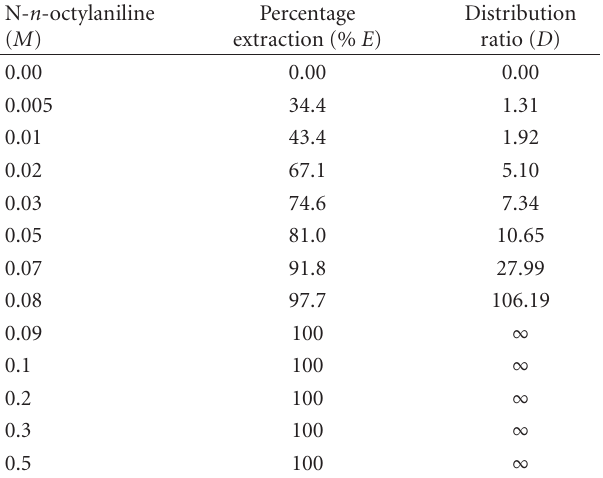
Table 1: Extraction behavior of neodymium(III) as a function of N- n -octylaniline concentration. Nd(III) = 60 μ g, sodium succinate